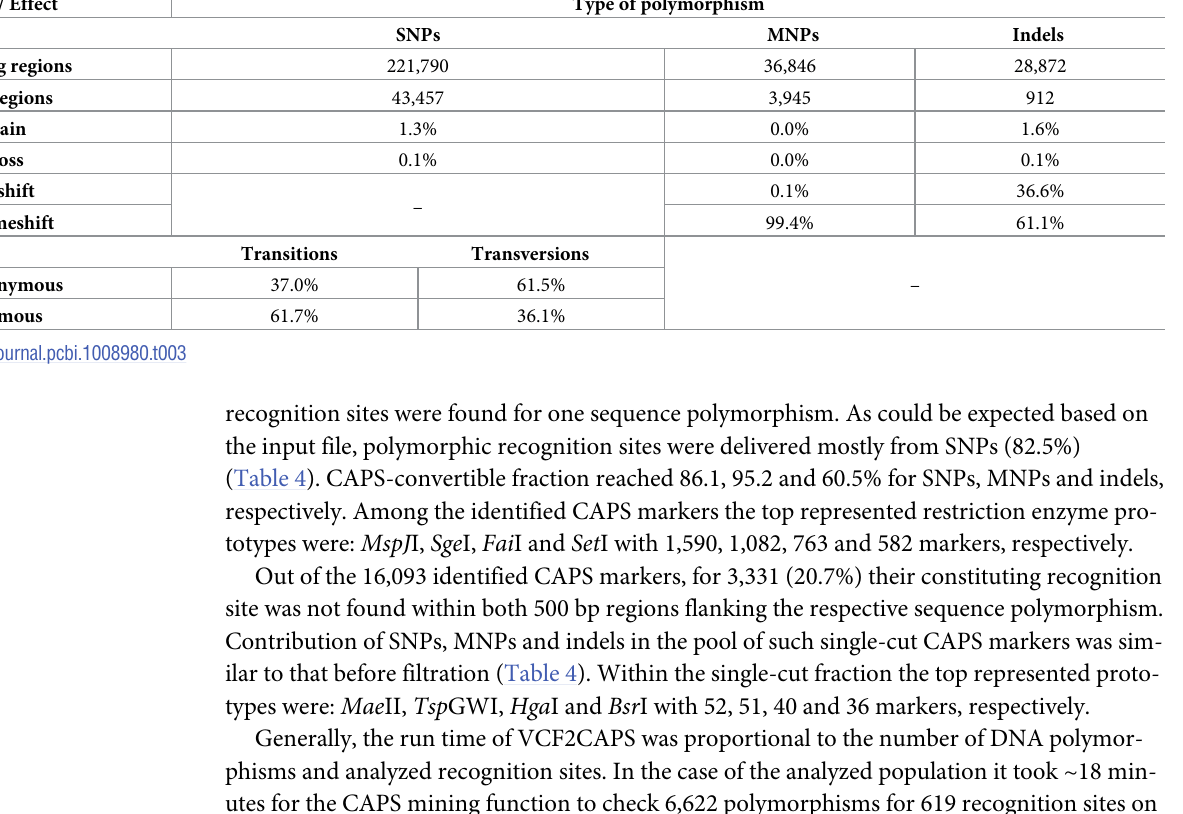
Table 3. Statistics of polymorphism annotation. Percentages were calculated only for polymorphisms located within the annotated coding regions. Location / Effect